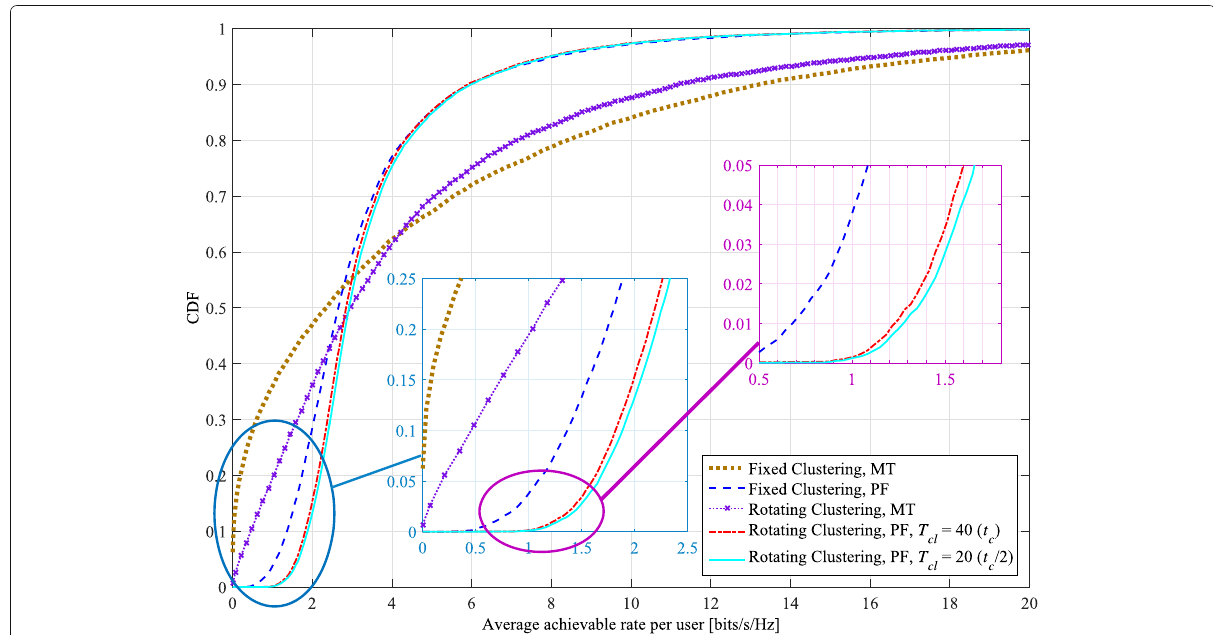
Fig. 9 CDF of average achievable per-user rate with both proportionally fair (PF) and maximum throughput (MT) scheduling metrics, comparing proposed rotating clustering scheme and fixed clustering for three-cell layout, using simulated annealing scheduling and SZF-DPC precoding. K c = 12, N macro = N pico = 2, M =